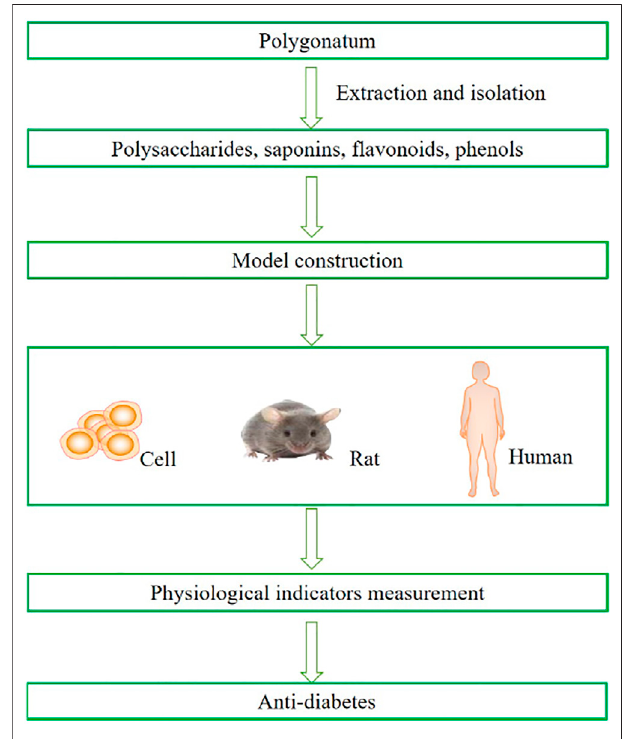
FIGURE 1 | Experimental work fl ow in the study of Polygonatum spp. in the treatment of